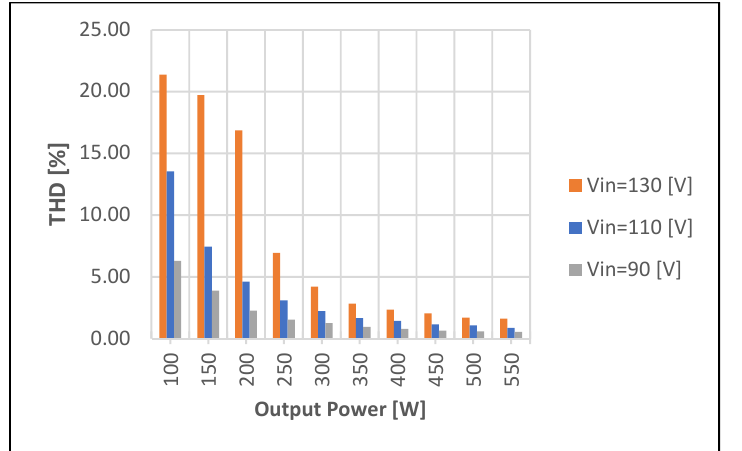
Figure 10. Laboratory practical total harmonic distortion measurements.